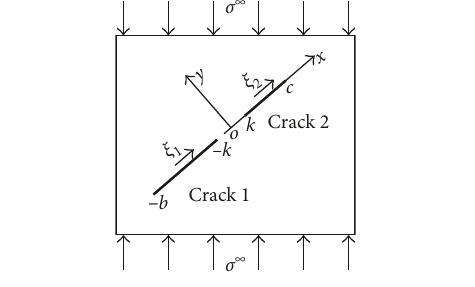
Figure 2: An infinite plate containing two unequal collinear cracks.